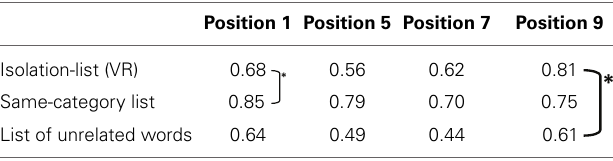
Table 3 | Probability of recall for the critical item only, in the different embedding lists.